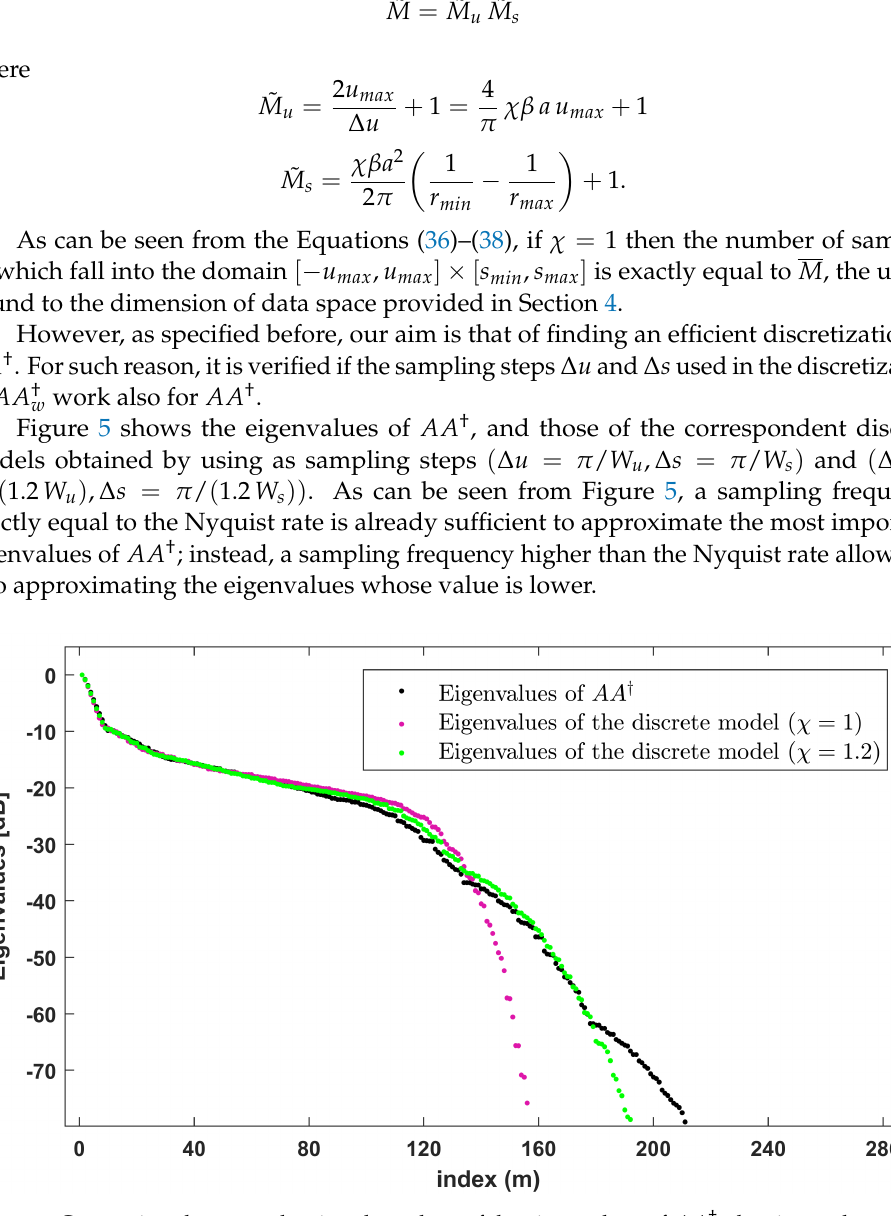
Figure 5. Comparison between the singular values of the eigenvalues of AA † , the eigenvalues of the discrete model when χ = 1, the eigenvalues of the discrete model when χ =